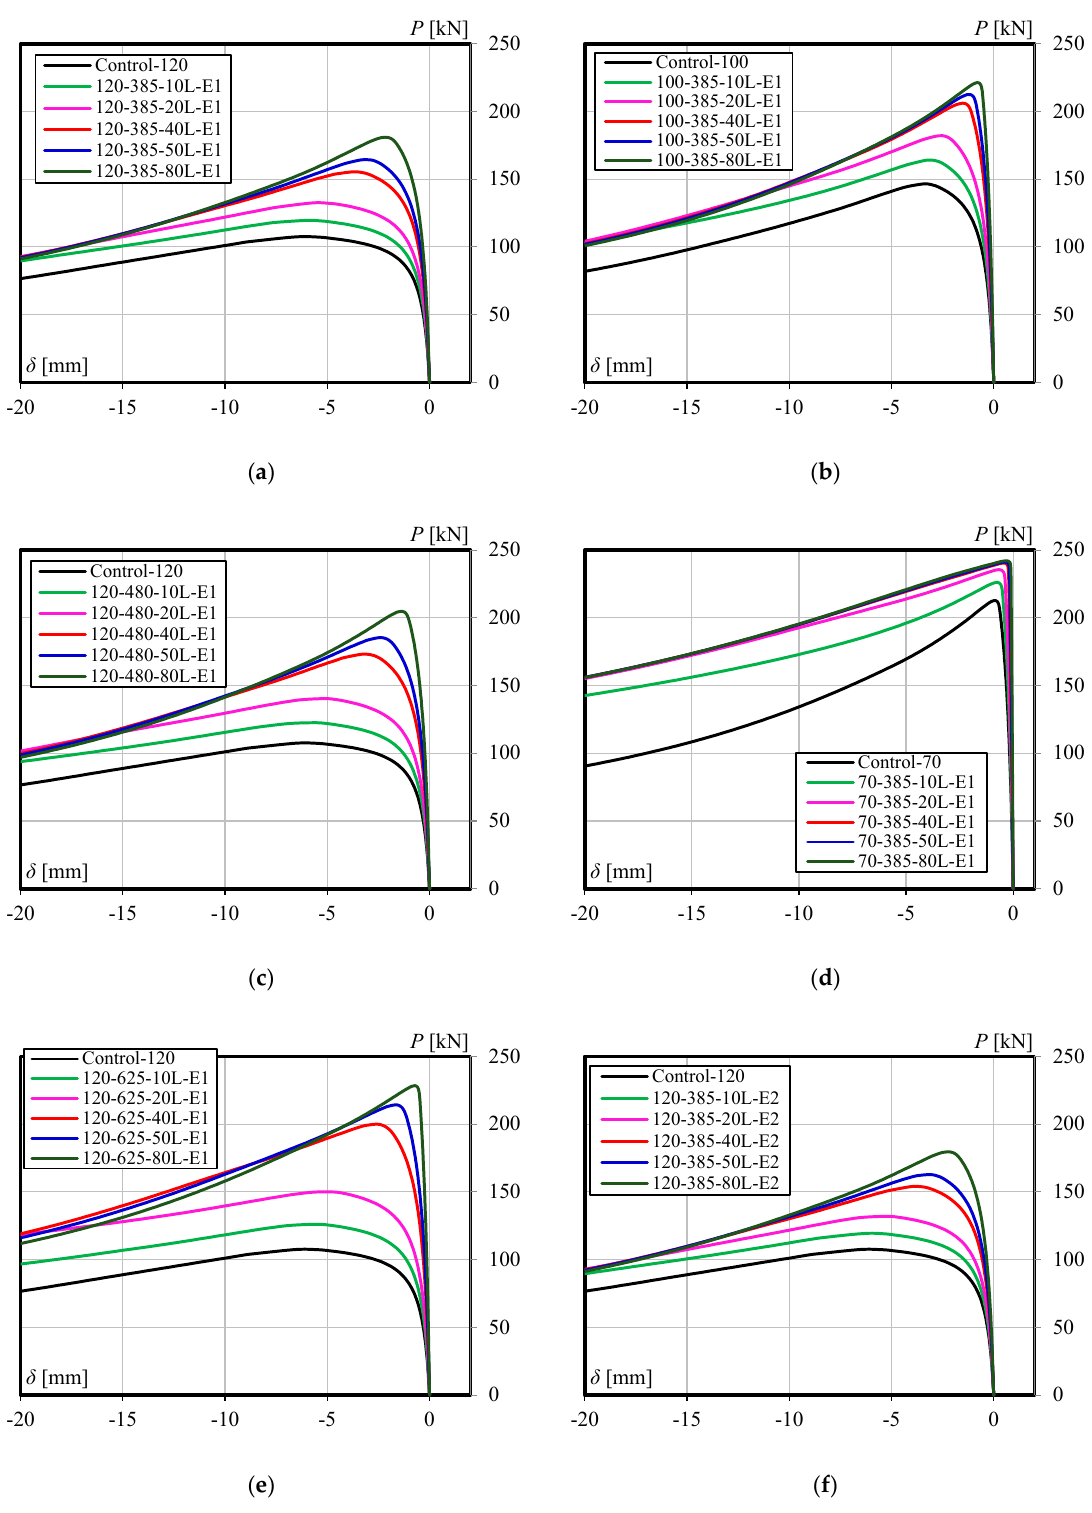
Figure 11. Load-lateral displacement behavior of all specimens: ( a ), ( c ), and ( e ) The member having slenderness ratio 120 with CFRP length of 385mm, 480mm, and 625mm, respectively; ( b ) and ( d ) The member having CFRP length of 385mm with slenderness ratio 100 and 70, respectively; ( f ) The member having slenderness ratio 120, CFRP length of 385mm, and CFRP modulus 68.72 GPa.